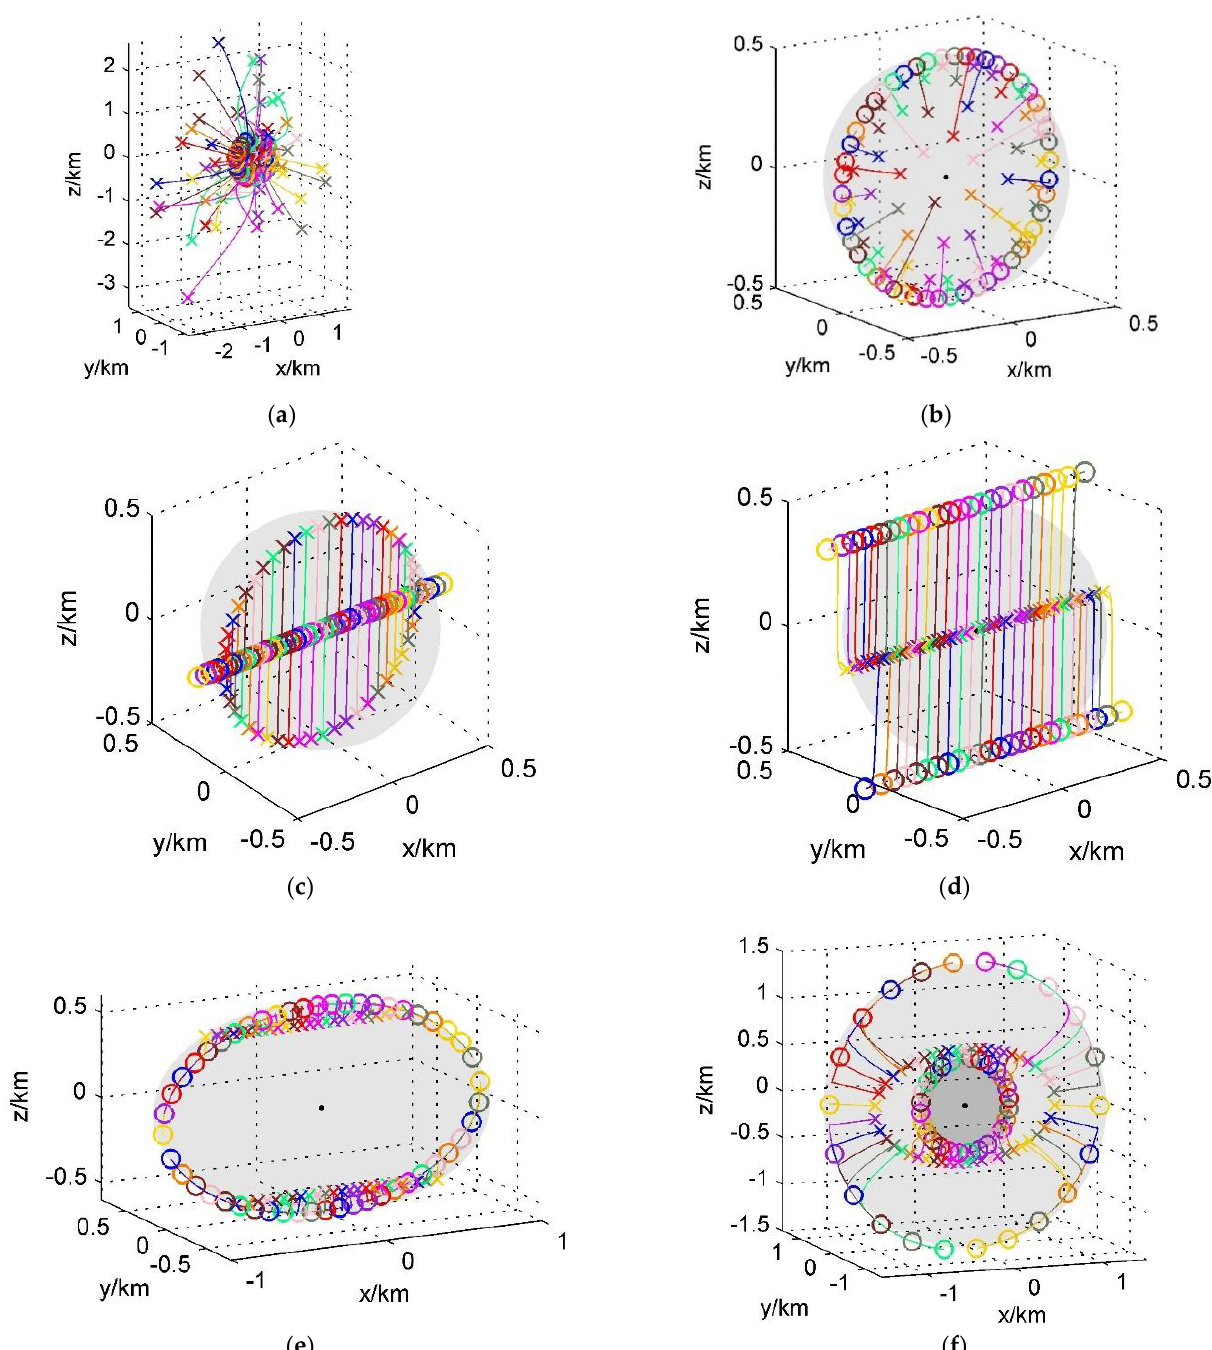
Figure 20. Satellite cluster formation reconfiguration. ( a ) The initial disk formation; ( b ) Switch from disk formation to circle formation; ( c ) Switch from circle formation to line formation; ( d ) Switch from line formation to double line formation. ( e ) Switch from double line formation to ellipse formation; ( f ) Switch from ellipse formation to concentric double circle formation.